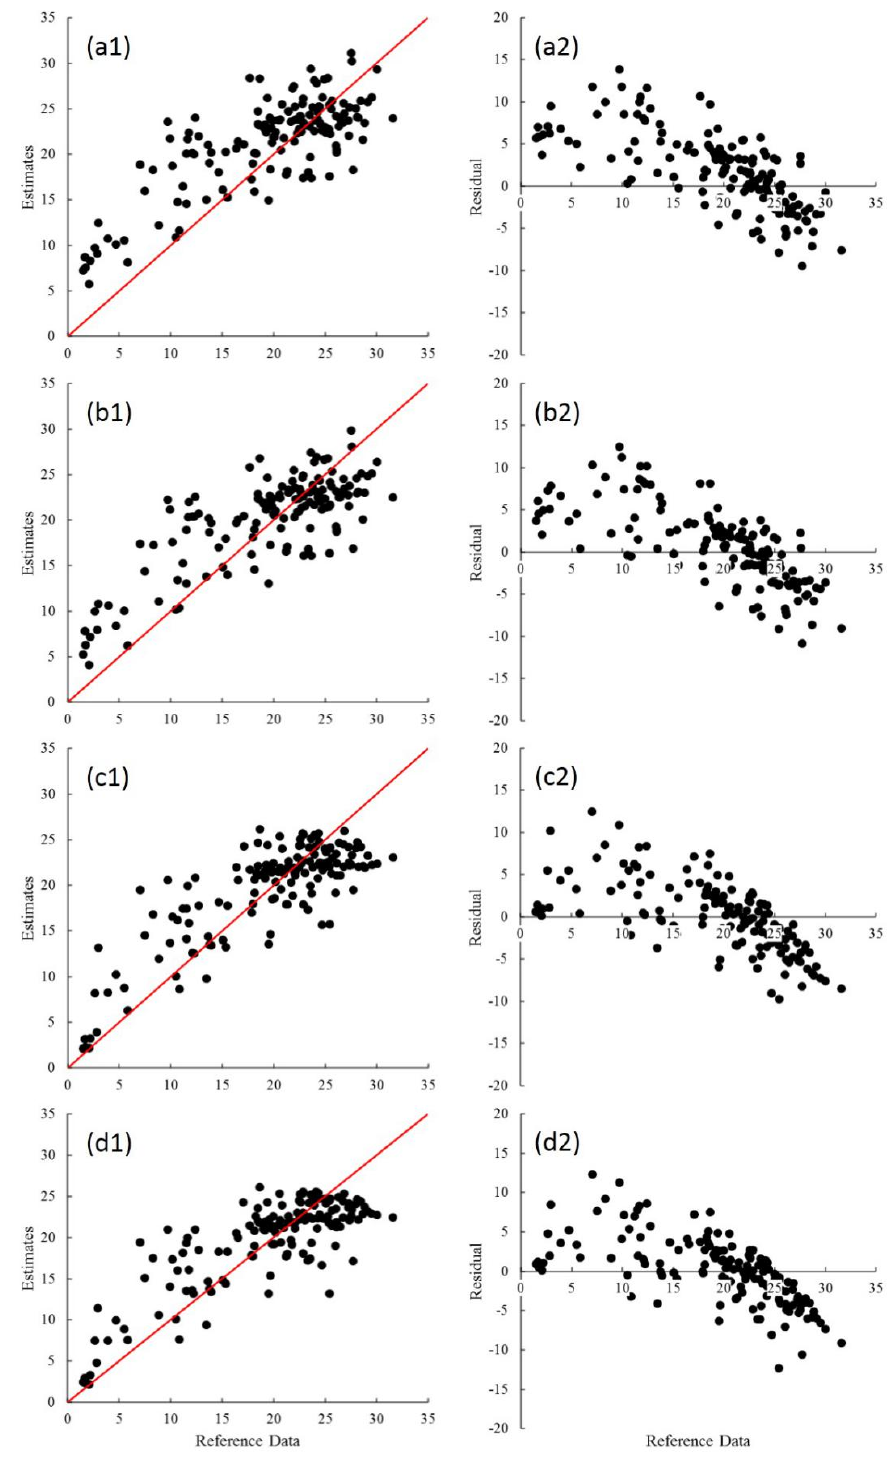
Figure 5. The relationships between forest aboveground carbon density (ACD) estimates and reference data: ( a1 , b1 ) linear regression models based on spectral indices alone and a combination of spectral indices and bands, respectively; ( c1 , d1 ) random forest models based on spectral indices and a combination of spectral indices and bands, respectively; ( a2 – d2 ) residuals of ACD estimates against reference data corresponding to each estimation model.